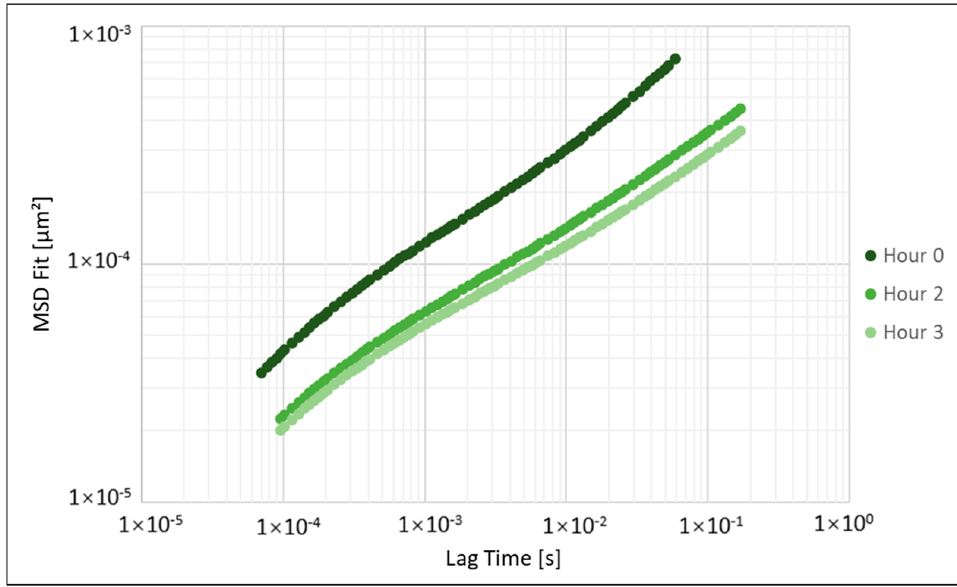
Figure 6. 3.25 wt % CAPB, 3.25 wt % SLES, 15 wt % avocado oil emulsion variation in MSD values over a 3 ‐ h period.